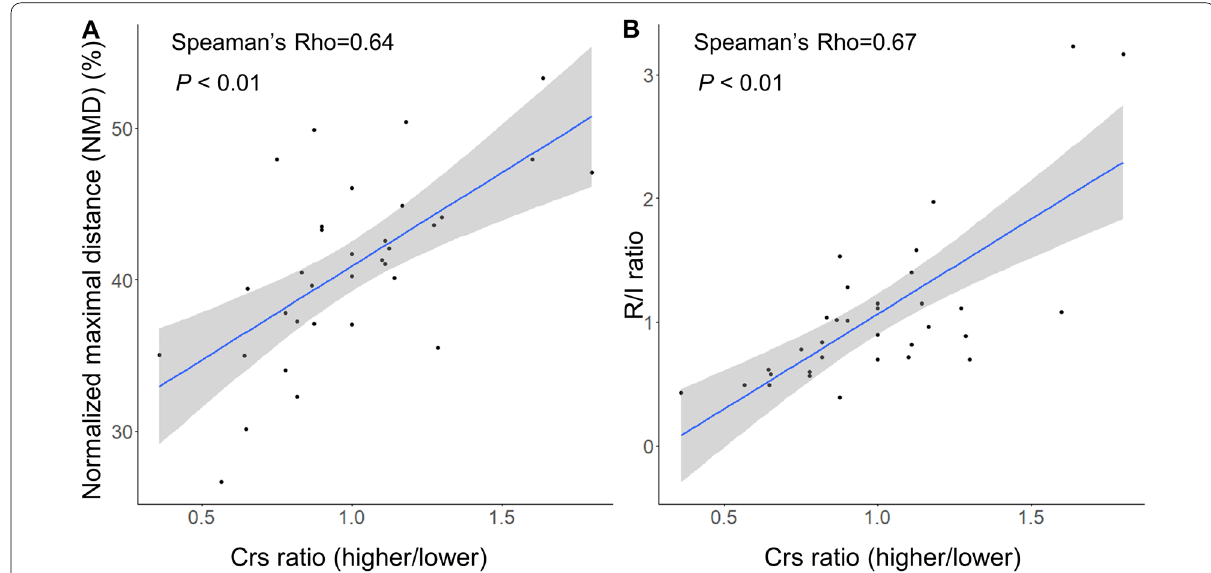
Fig. 4 Correlation between compliance and recruitability items. A The ratio of respiratory system compliance ( C rs ) at higher PEEP (15 or 18 cm H 2 O) to C rs at lower PEEP (5 or 8 cm H 2 O) (termed, C rs ratio (higher/lower)) moderately correlated with NMD (rho (rho 0.67, P < =